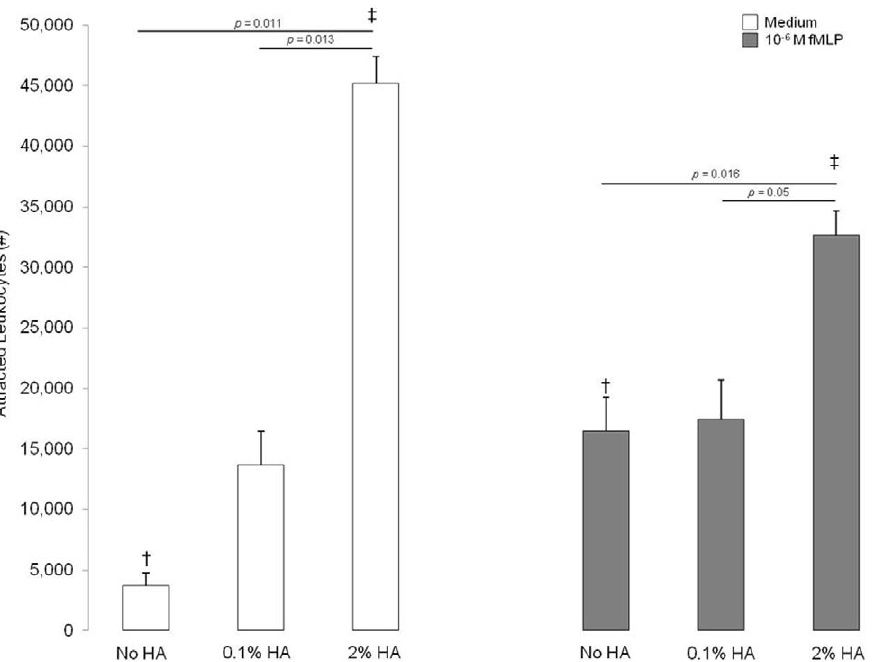
Figure 6. Effect of HA on leukocyte chemotaxis. CBFCAs were performed using medium or 10 2 6 M fMLP, in the absence or presence of 0.1% and 2% HA. The addition of 2% HA to the medium and 10 2 6 M fMLP attracted more leukocytes; however, it also masked the chemotactic activity of 10 2 6 M fMLP. Data are shown as means 6 SD of five independent assays in triplicate. Means with same symbol are significantly different. Significance was determined by ANOVA, Games-Howell tests and T test ( p= { { 0.027).